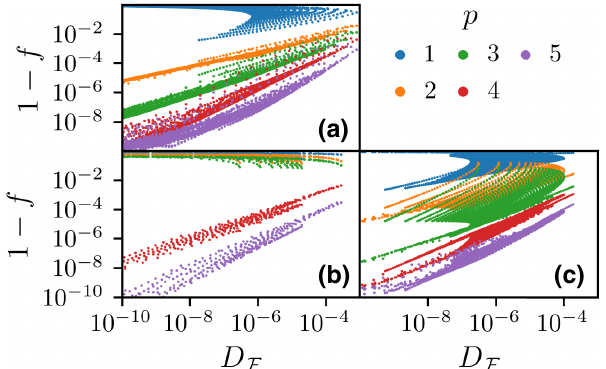
FIG. 3. (a) Scatter plot of the interaction distance D F against the QAOA’s 1 − f for the FM Ising model from Fig. 2(c). (b),(c) Analogous plot for the AFM Ising model in Fig. 2(d), where the data points are taken either (b) below or (c) above the critical line. Data are for N = 8 spins with PBCs and different values of p indicated in the